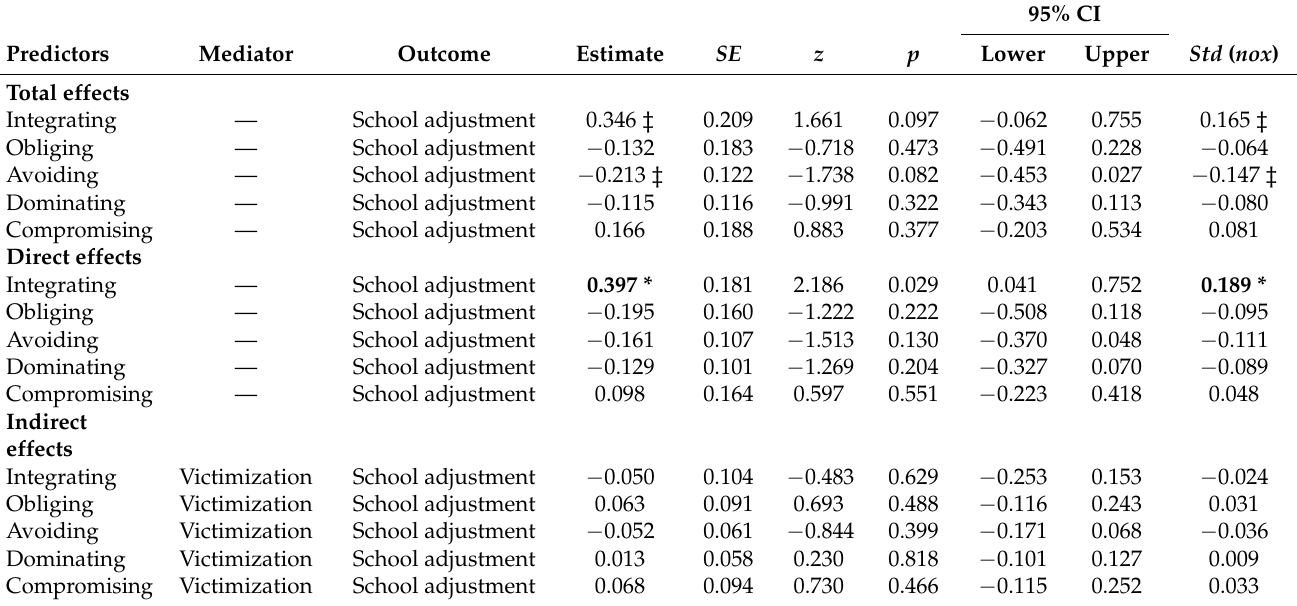
Table 2. Total, Direct, Total Indirect and Indirect Effects of Victimization Mediating the Association Between Conflict Management Styles and Psychological School